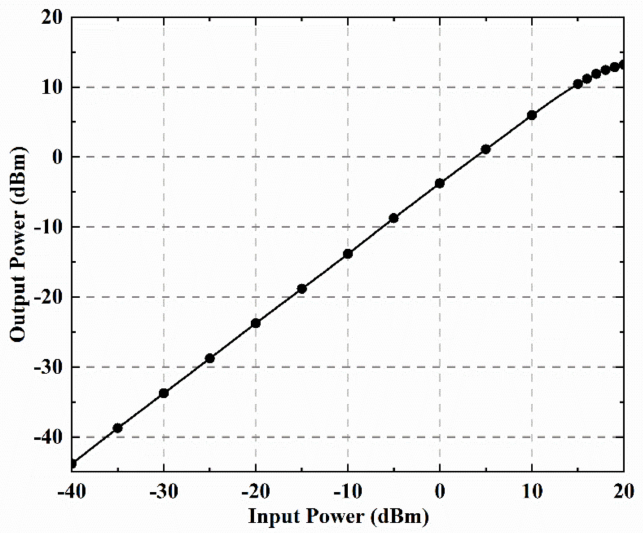
Figure 13. The P 1dB of the proposed single-chip switch when the input frequency is 1 GHz and the P 1dB is approximately 15 dBm.